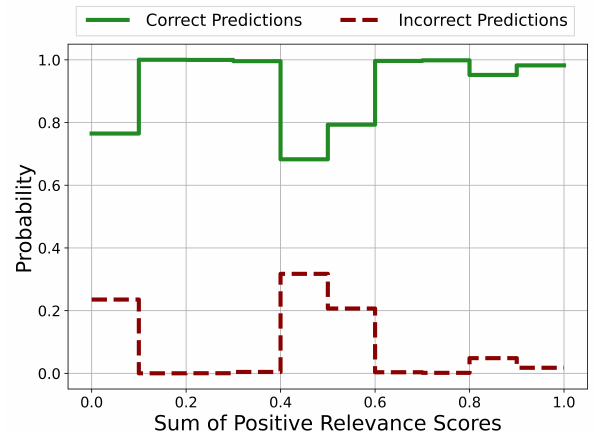
Figure 18. Probability distribution of the sum of positive Relevance scores for correct (green solid line) and incorrect (red dashed line) predictions on the test set.Predictions with sums of positive Relevance values with 0.0 < sum < 0.1 and 0.4 < sum < 0.6 are unreliable. Predictions with 0.8 < sum < 0.9 can be considered as slightly